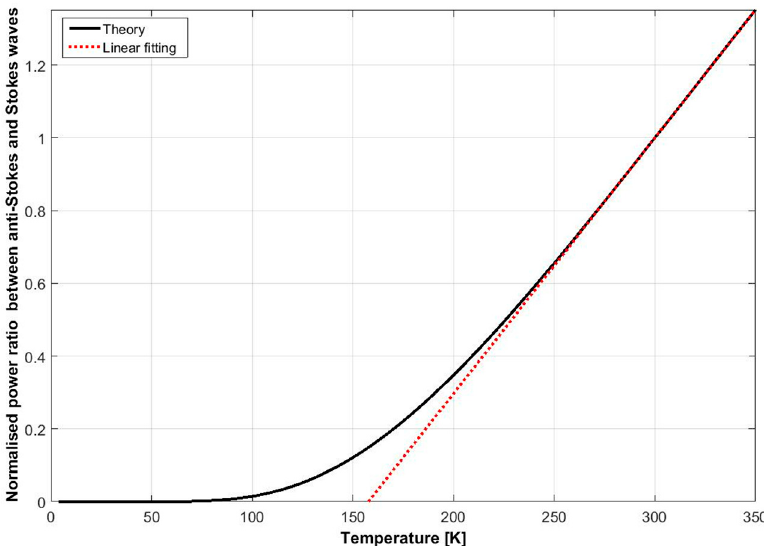
Figure 3. Normalised ratio between anti-Stokes and Stokes waves of Raman scattering as a function of temperature. A linear relationship between the temperature and the ratio is observed from ~250 K to 350 K.